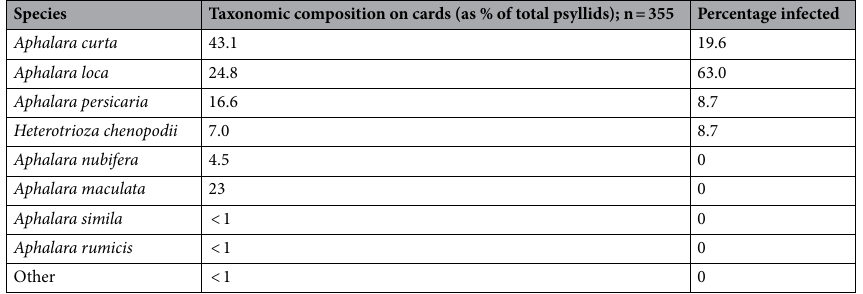
Table 5. Taxonomic composition generated from sequencing the CO1 gene from a subset of the specimens removed from the sticky card traps and percentage of infected specimens for each